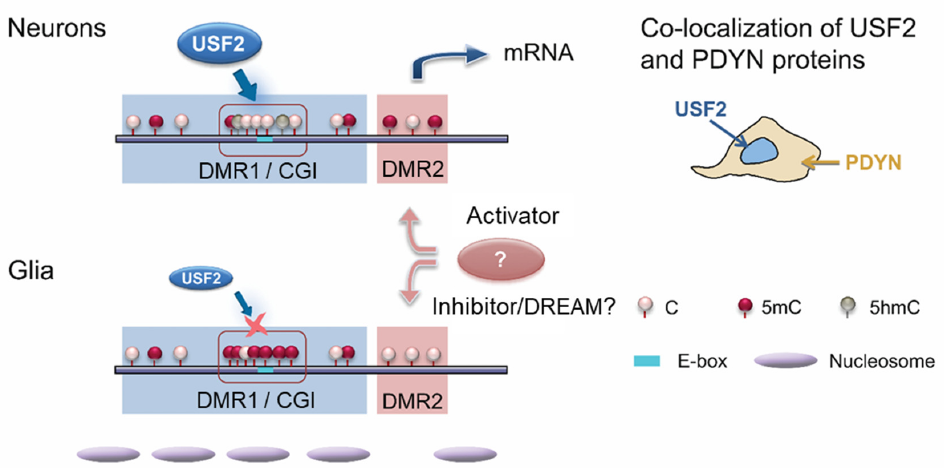
Figure 5. Model for epigenetic and transcriptional regulation of neuronal PDYN transcription. In neurons, USF2 binds to E-box in the promoter CGI that is hypomethylated and enriched in 5-hydroxymethylcytosine (5-hmC). In glia, the CGI is hypermethylated. DMR2 and DMR1/CGI exhibit methylation patterns that are opposite between them and between neurons and glia for each of them. In non-neuronal cells, DMR2 may be targeted by methylation-sensitive transcriptional repressor such as DREAM, while in neurons by a methylation-dependent transcriptional activator. In glia, the DMR1/CGI may be wrapped in a nucleosome, that prevents transcriptional initiation. These mechanisms may underlie contrasting PDYN expression in neurons and glia. Modified from [79].